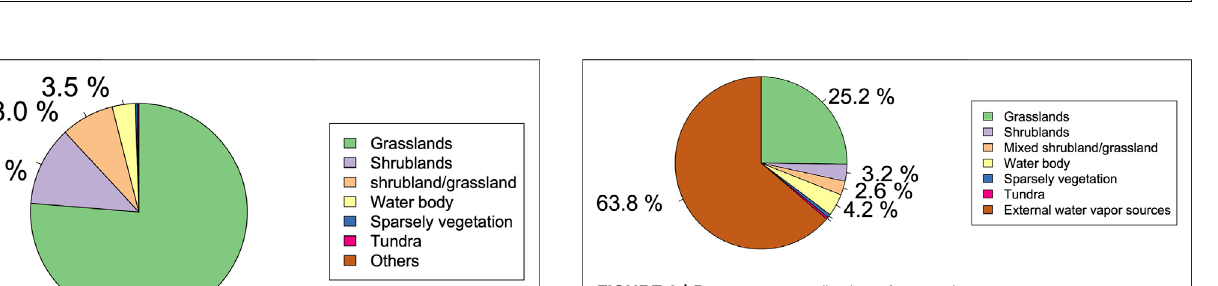
FIGURE 9 | Percentage contribution of external water vapor sources and evapotranspiration from different underlying surfaces to precipitation in the Yellow River source area during May to September